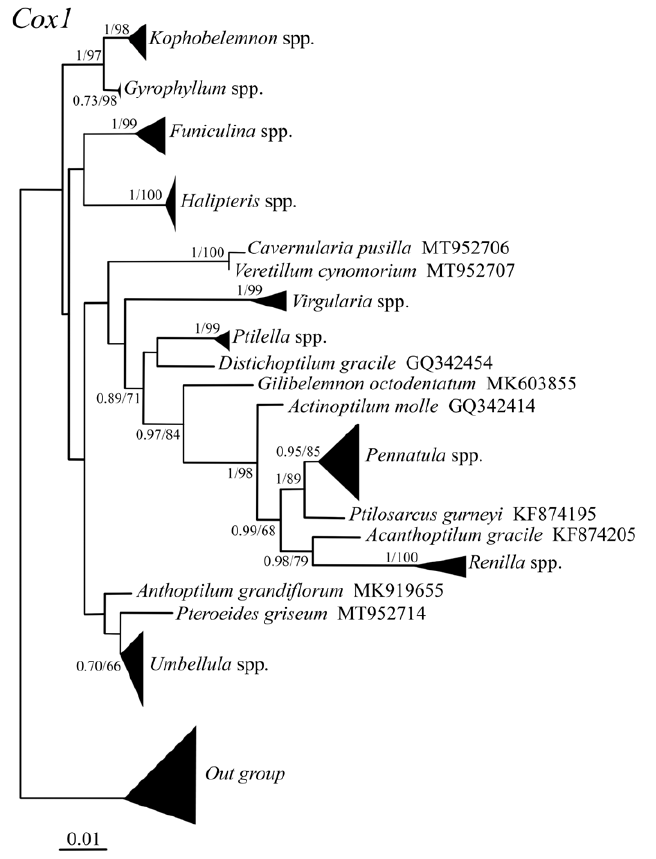
S3. – Phylogenetic relationships in the order Pennatulacea based on the maximum likelihood method for the marker Cox1. Posterior probability and bootstrap supporting values are indicated on the different nodes. See Table 1 for species and GenBank accession numbers used in this tree.